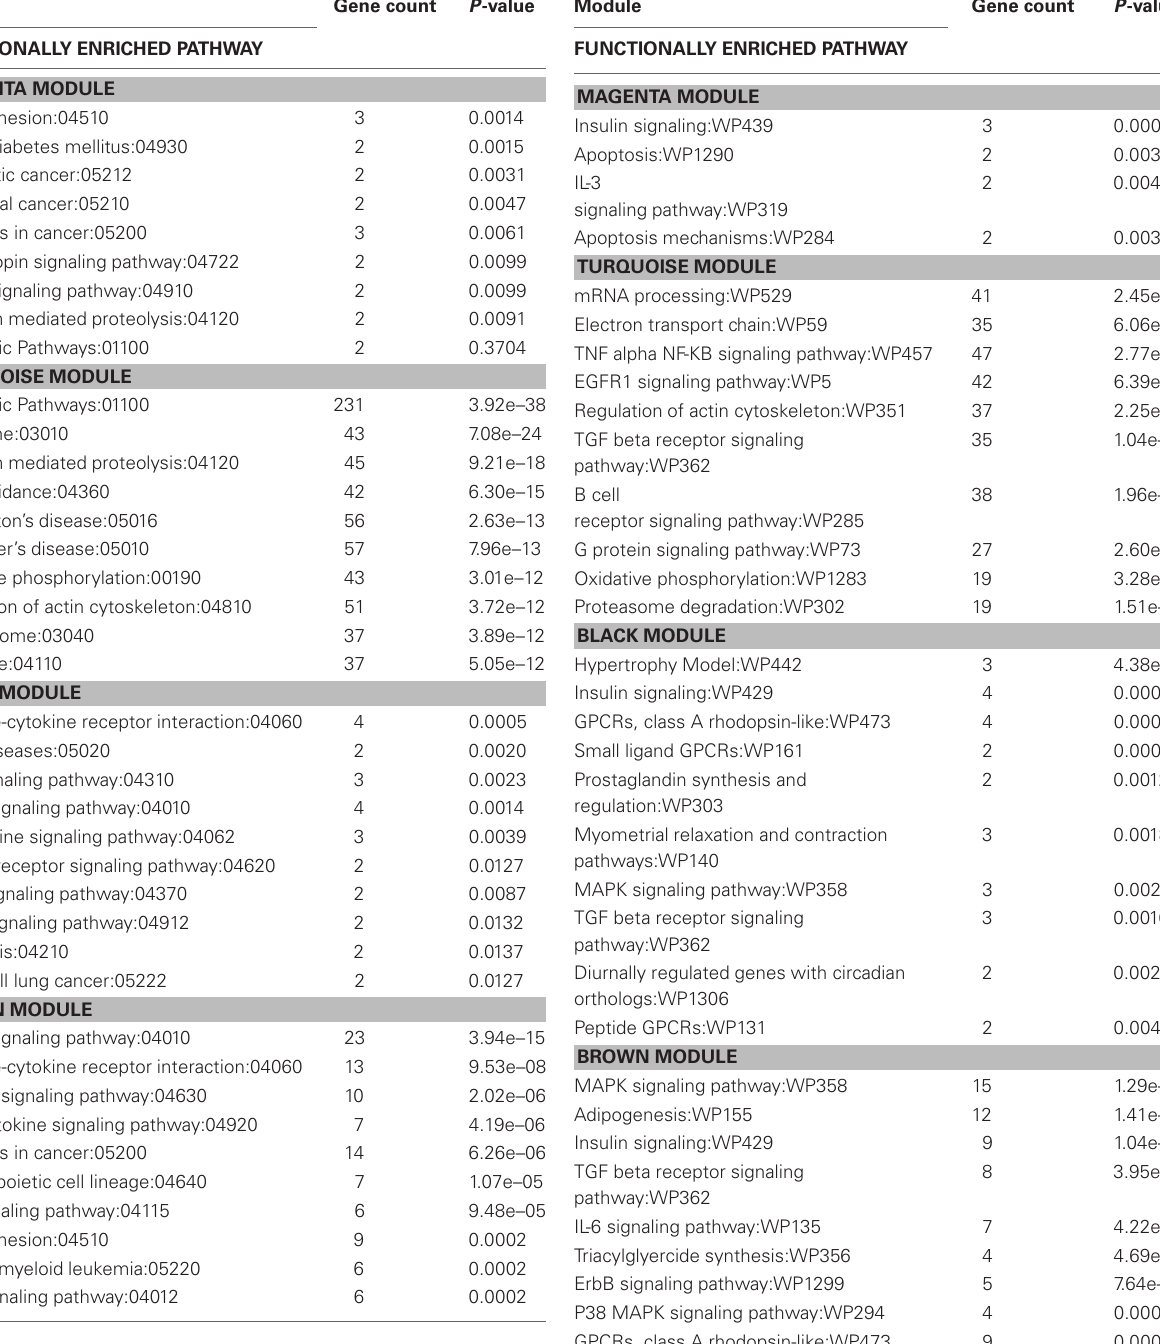
Table 6 | Wiki functionally enriched pathway categories generated from modules of genes correlated to exercise and/or stress.